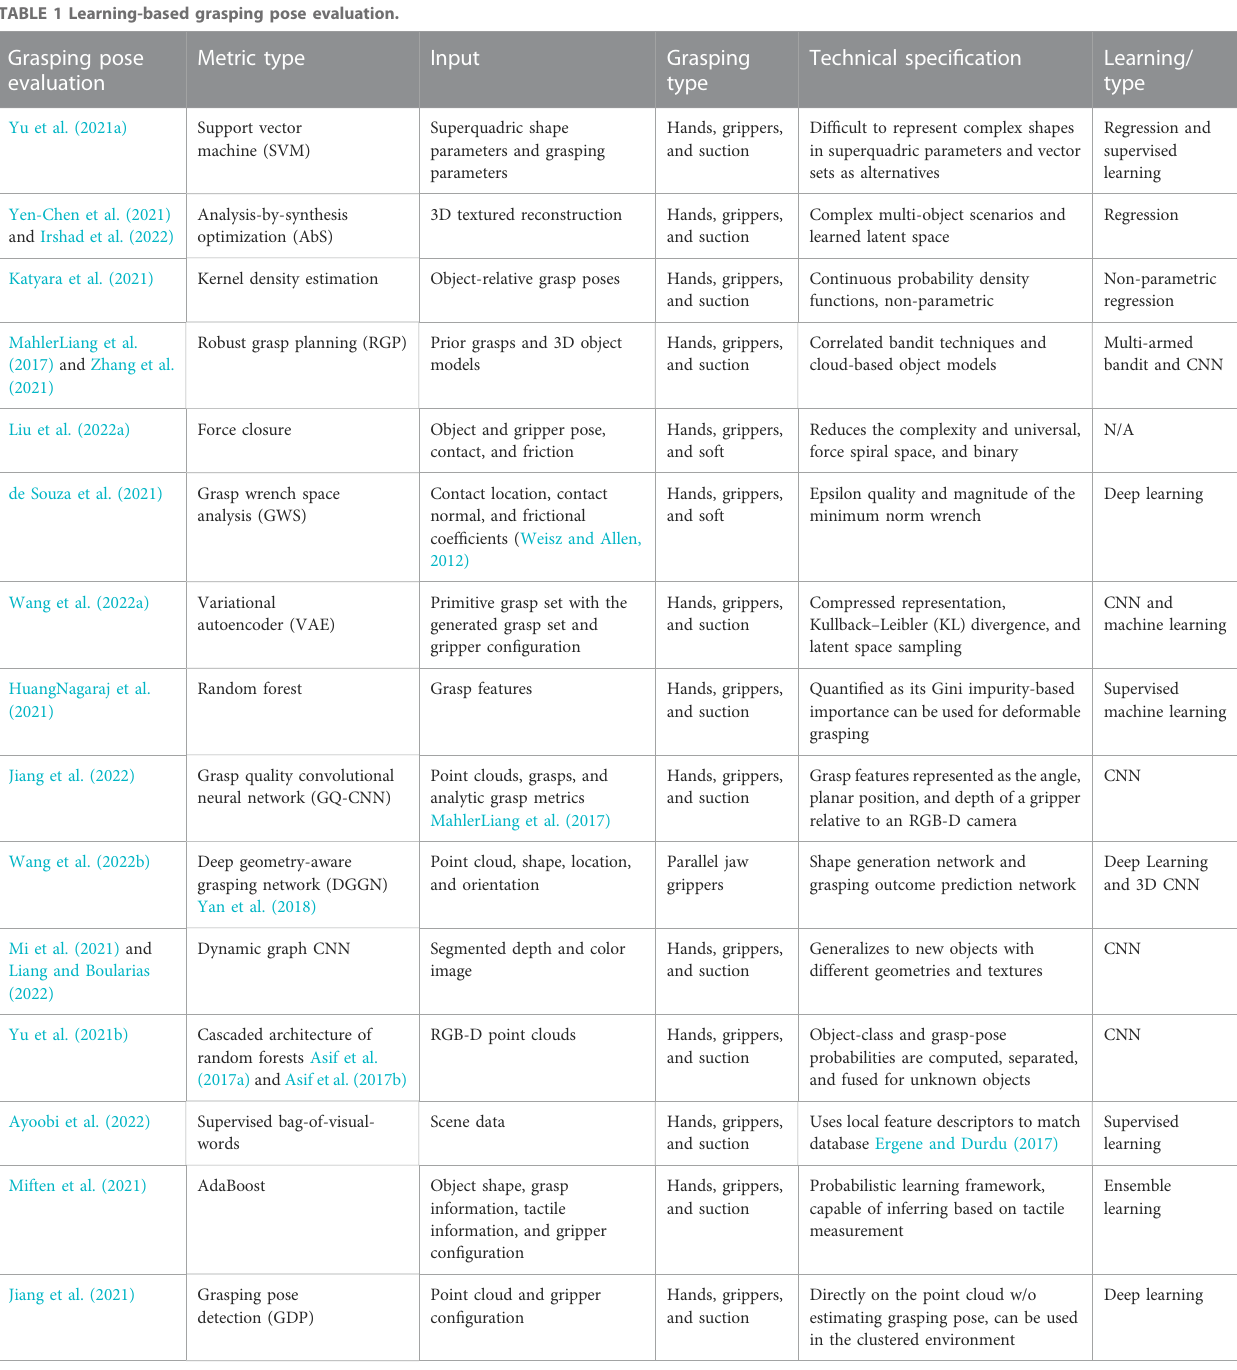
TABLE 1 Learning-based grasping pose